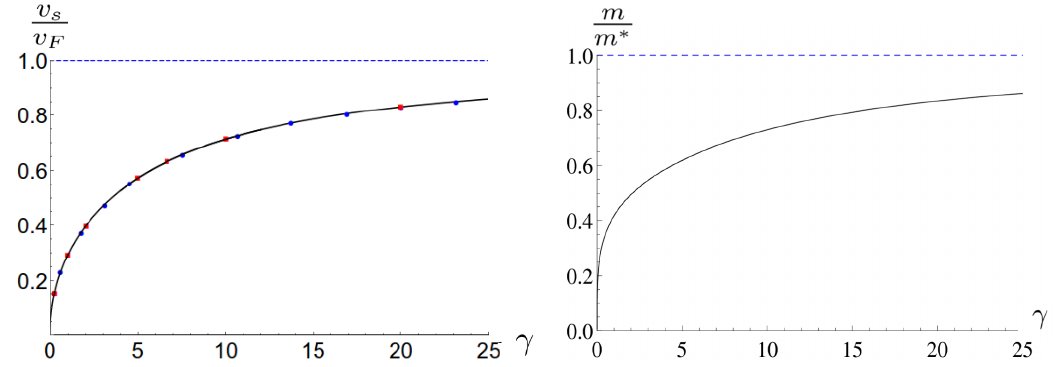
/ v , where v is the Fermi velocity, s F F